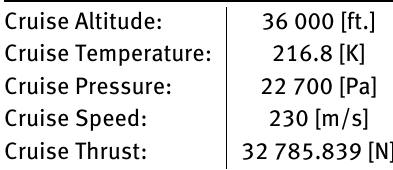
Table 1: Fixed Engine and Flight